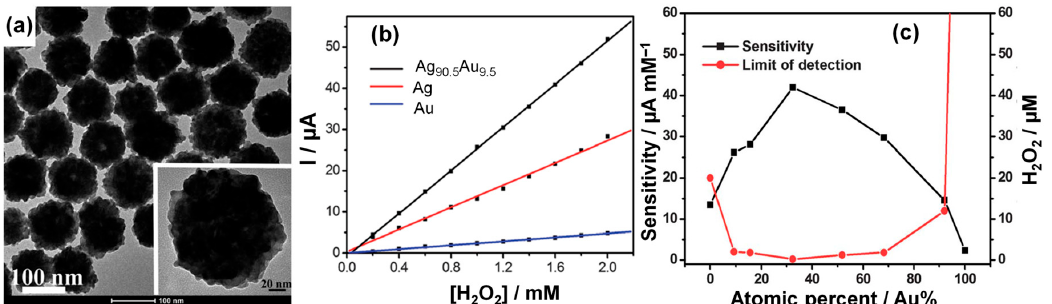
Figure 8. ( a ) TEM image of Ag ‐ Au bimetallic material for the fixed ratio of [Ag + ]/[Au III ] = 1:0.1 during the synthesis, the inset is a HRTEM micrograph; ( b ) Calibration curves from the amperometric responses of Ag 90.5 Au 9.5 ‐ (black), Ag ‐ (red) and Au ‐ (blue) modified GC electrodes at E applied = − 0.5 V vs. Ag|AgCl|KCl sat stirred in a 0.1 M PBS; ( c ) Plots of the sensitivity (the black line) or the low detection limit (the red line) versus the atomic percentage of Au. Reprinted and adapted with permission from Reference [137]. Copyright The Royal Society of Chemistry, 2013.